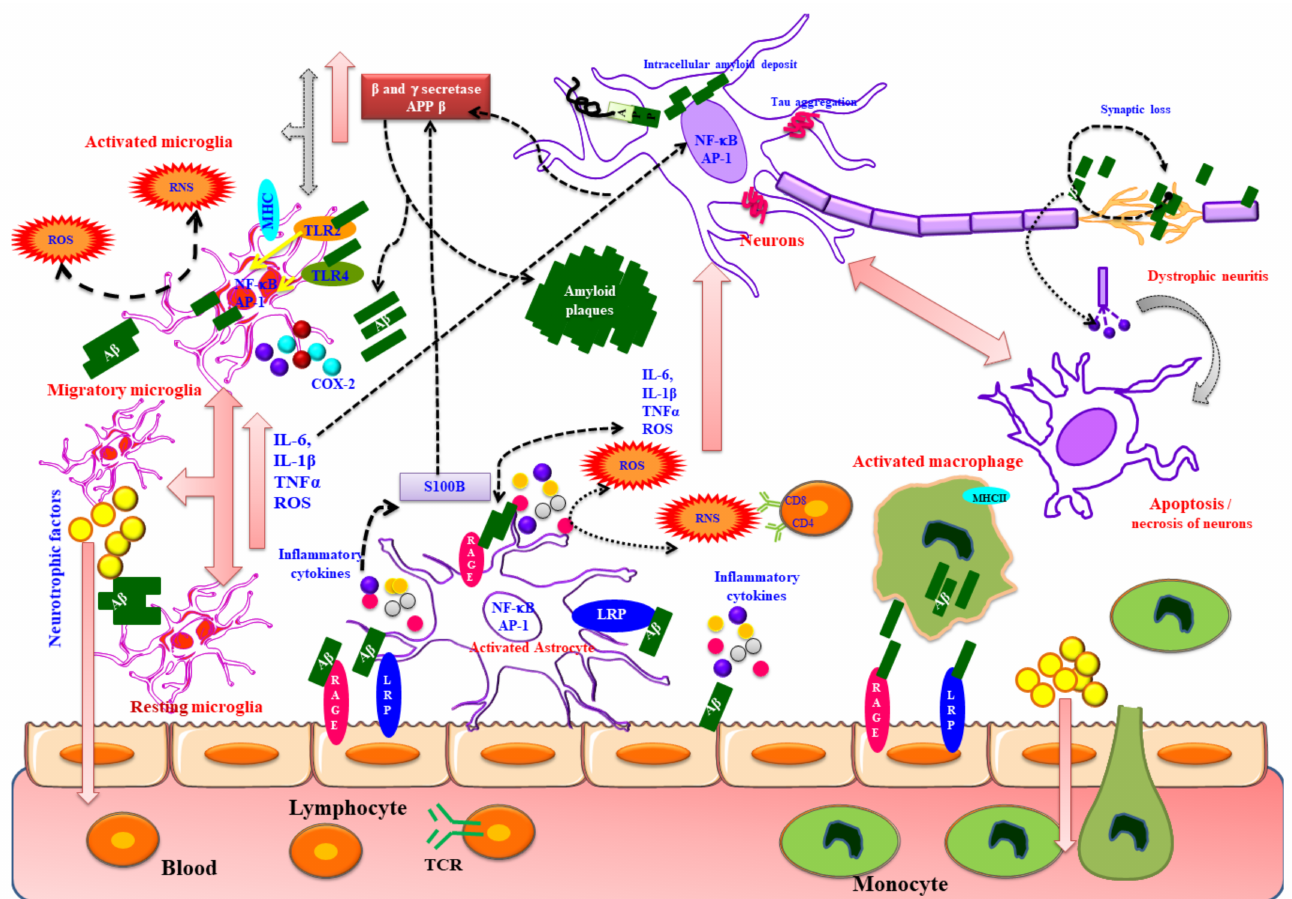
Figure 5. Neuroinflammation in the pathogenesis of Alzheimer’s disease: A β activates microglial cells via TLR and RAGE receptors which stimulates the NF- κ B and AP-1 transcriptional factors leading to release of inflammatory cytokines (IL-1, IL-6, TNF α ), ROS and RNS inducing oxidative/nitrosative stress mediated neuronal damage. Inflammatory cytokines stimulate astrocytes leading to amplification of inflammatory signals inducing neurotoxic effect. Chemokines also attracts peripheral immune cells towards amyloid plaque exacerbating inflammatory